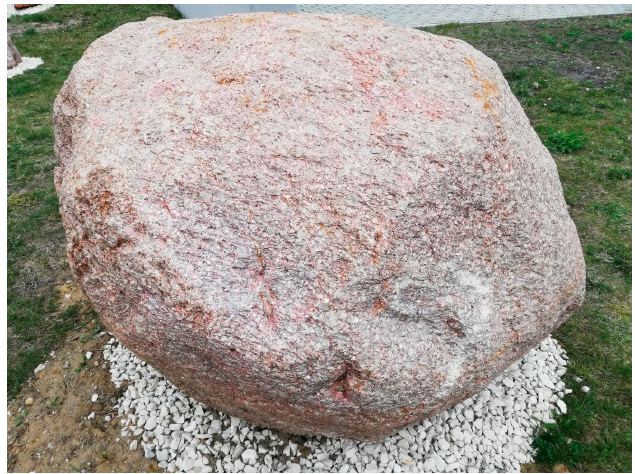
Figure 11. Åland rapakivi granite with a clear corrosion microrelief (No. 16).